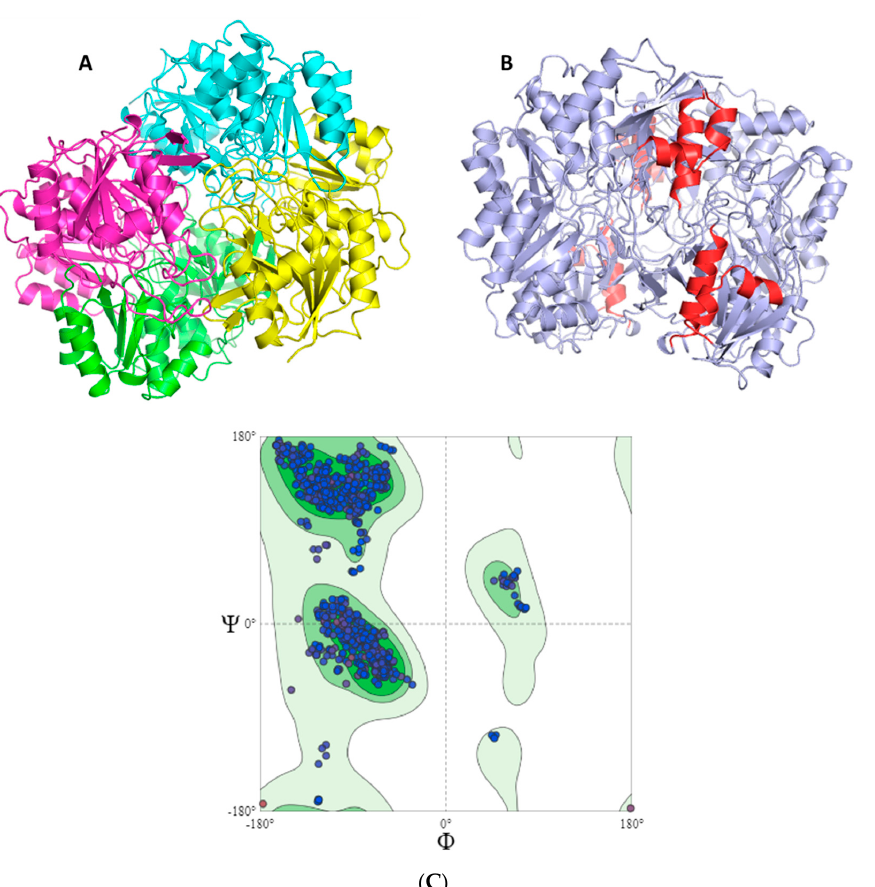
Figure 3. Humanized chimeric E. coli L-asparaginase with fragments of human L-asparaginase 4O0H and evaluation of the accuracy of the predicted protein structure. ( A ) The humanized 3ECA- derived chimeric enzyme is shown in tetrameric conformation with four independently folded sub- units. Subunit A is shown in green, subunit B in cyan, subunit C in magenta, and subunit D in yel- low. ( B ) The humanized 3ECA-derived chimeric enzyme is shown; the fragments of human L-as- paraginase 4O0H that were substituted are shown in red. ( C ) Ramachandran diagram for the chi- meric L-asparaginase protein. Observed values of the Φ and Ψ angles (blue point) for all humanized 3ECA-derived amino acids in the chimeric protein. In dark green are presented the allowed and favorable zones. In light green, the less favorable zones are presented and in lighter green and white, the most unstable and prohibited areas, respectively, where the combinations of the Φ and Ψ angles are not allowed by steric hindrance. In the fi rst quadrant, the left α -helix combinations are repre- sented, in the second quadrant are the β -sheet combinations, and in the third quadrant are the right α -helices and loops. The chimeric protein was characterized by a stable conformation with most of the amino acids in the allowed zone. It was characterized by a predominance of right α -helices and β -sheets. In the subunits of the obtained chimeric enzyme, it can be estimated that a single subunit is composed of two polypeptide clusters with a wide density of amino acids that fold independently, forming loops and turns, beta sheets, and alpha helices. In addition, it is observed that these dense populations of amino acids are connected by a loop extend- ing from amino acid 190 to approximately 213. Although this analysis is inconclusive, it provides us with an approximation of how the protein structure is maintained in the face of the imposed modi fi cations (Figure 4).